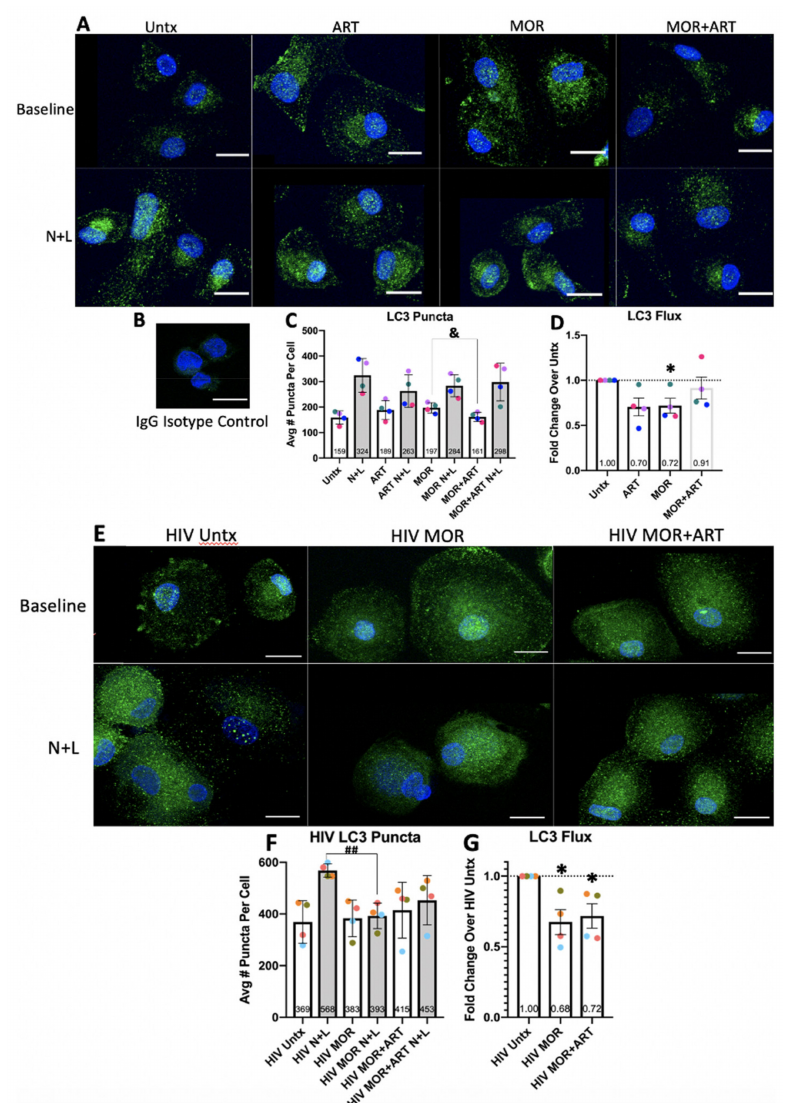
Figure 2. LC3 immunofluorescence studies in uninfected and HIV-infected MDM. Primary human macrophages were cultured on coverslips, infected with HIV or not, left untreated (Untx or HIV Untx) or treated with morphine and/or ART for 24 h with N+L added to some cells in the last 4 h of treatment, and coverslips were stained for LC3. Cells were imaged by confocal microscopy in Z-series, and LC3 puncta/cell were determined. ( A ) Representative uninfected untreated cells or cells treated with morphine and/or ART in the presence and absence of N+L. ( B ) Image of an IgG isotype-matched negative control at equivalent confocal laser exposure. ( C ) Average number of LC3 puncta per cell across treatments. ( D ) LC3 flux calculated relative to untreated control set to 1.0 using values for average number of LC3 puncta/cell. ( E ) Representative HIV-infected untreated cells or cells treated with morphine and/or ART in the presence and absence of N+L. ( F ) Average number of LC3 puncta per cell across treatments. ( G ) LC3 flux calculated relative to untreated control set to 1.0. Scale bar is 15 µ m. Puncta/cell were quantified in a blinded fashion in 40–80 cells per treatment condition for each experiment and averaged. Error bars for puncta values represent SD, and error bars for LC3 flux represent SEM, n = 4 independent experiments, * p < 0.05, one-sample t -test, & p < 0.05 one-way ANOVA MOR compared to MOR+ART, ## p < 0.01, one-way ANOVA HIV MOR N+L compared to HIV